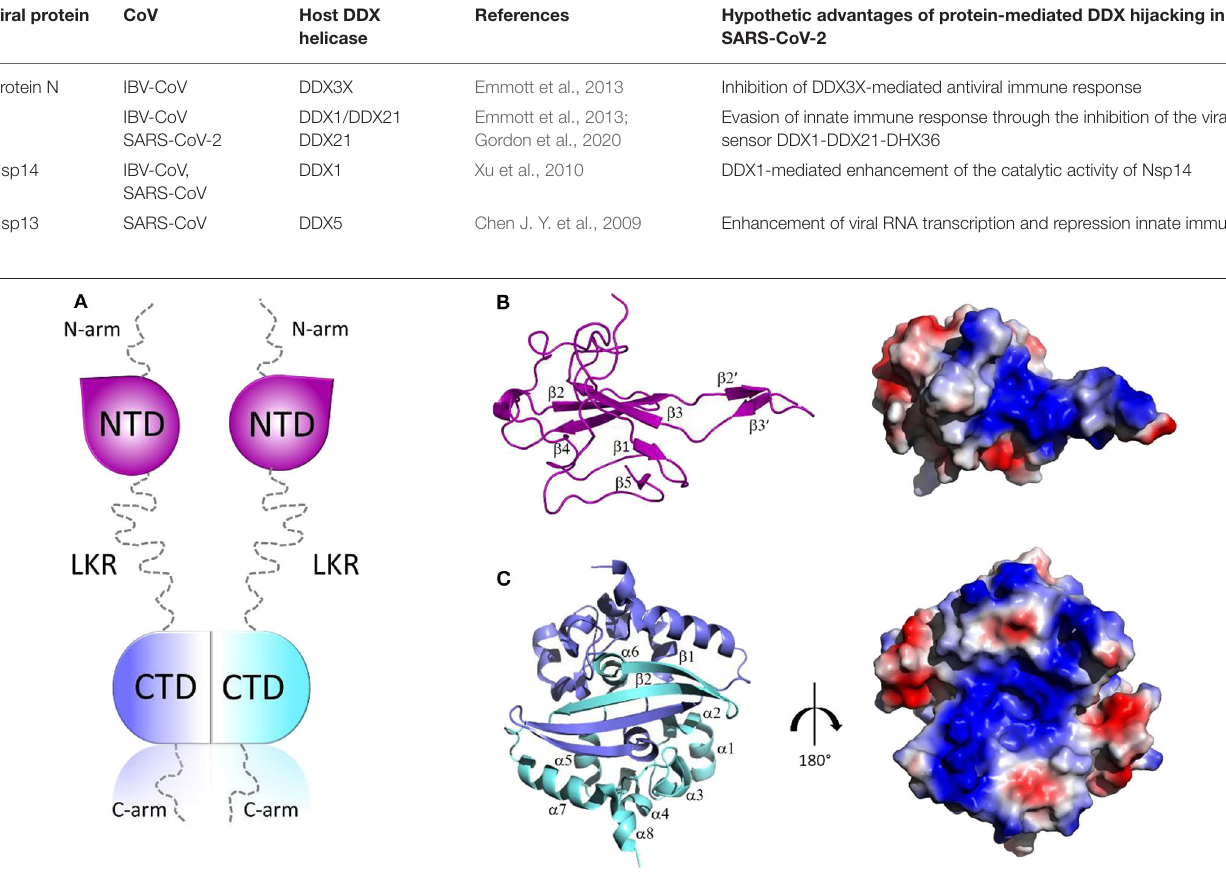
FIGURE 2 | Structural overview of SARS-CoV-2N protein. (A) Schematic representation of SARS-CoV-2N protein; (B,C) Cartoon representations and corresponding electrostatic potential surface charge distributions of SARS-CoV-2 NTD ( PDB code: 6M3M) and SARS-CoV-2 CTD (PDB code:6YUN),